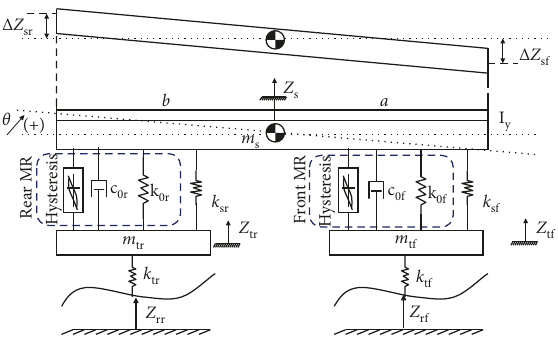
Figure 2: A 4-DOF one-half semiactive